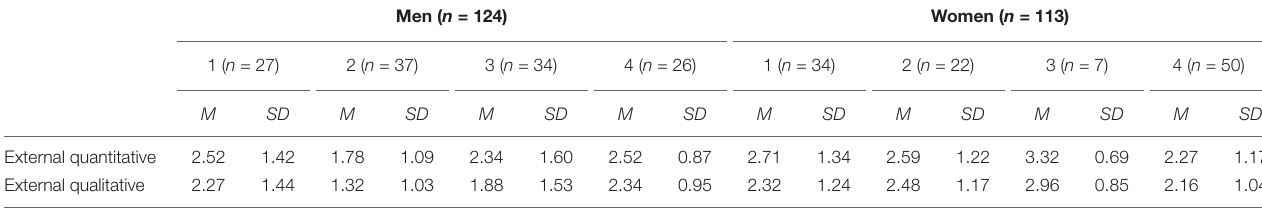
TABLE 3 | Descriptive statistics of employability by sex and gender identity among unemployed ( n = 237).